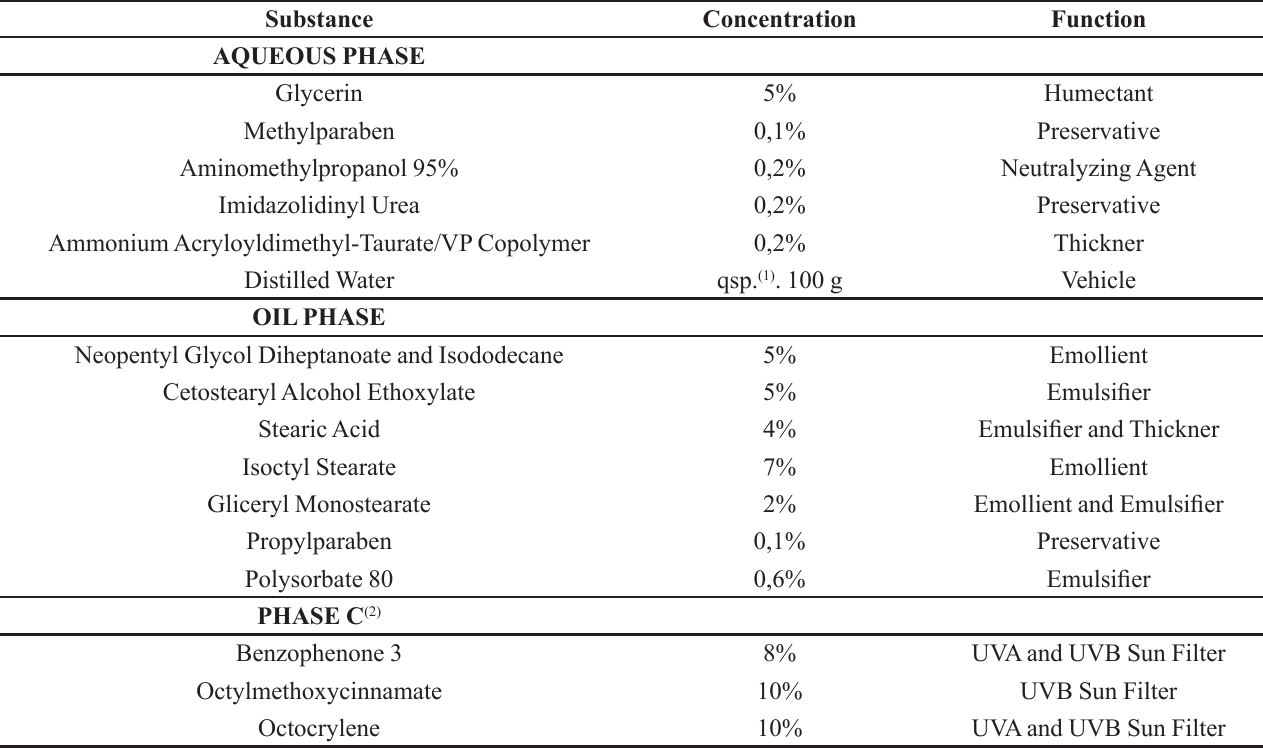
TABLE II - Formulation of non-pigmented and photoprotective emulsive base